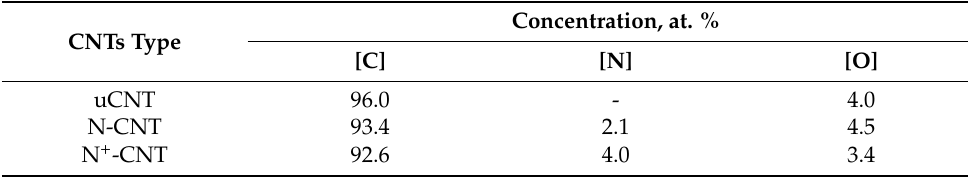
Table 1. Chemical analysis of the samples by